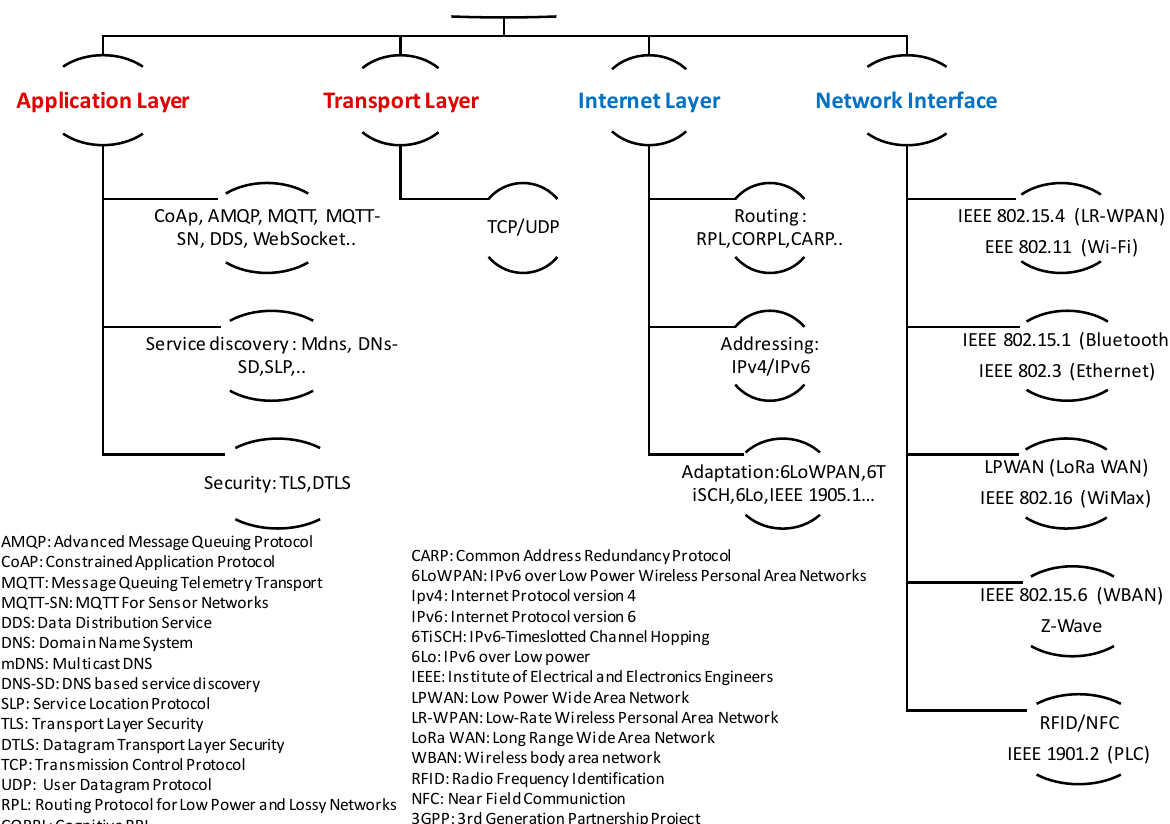
Summary of most prevalent protocols according to the levels of IoT architecture